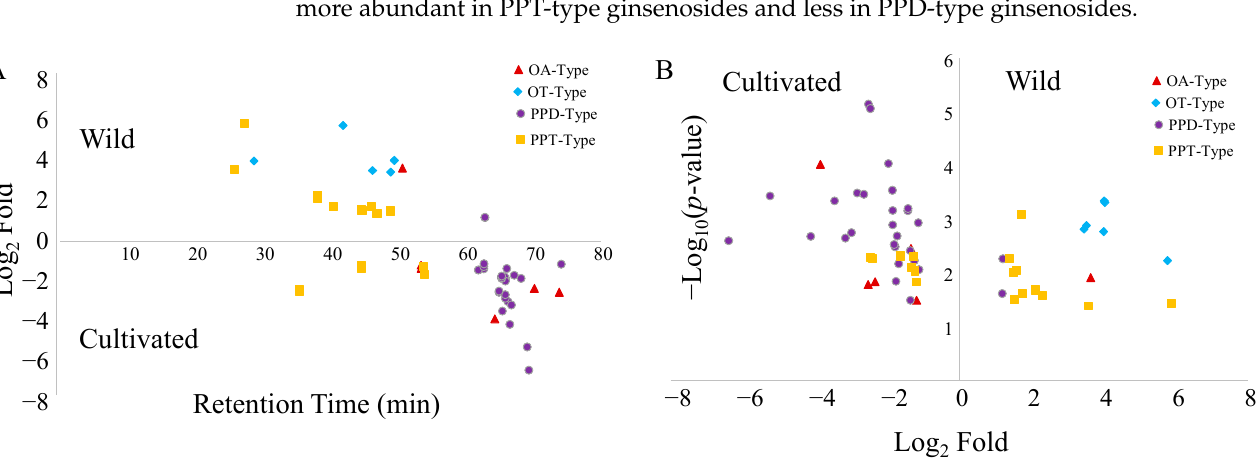
Figure 4. Distribution trends of ginsenoside types based on retention times ( A ) and growth environments ( B ).